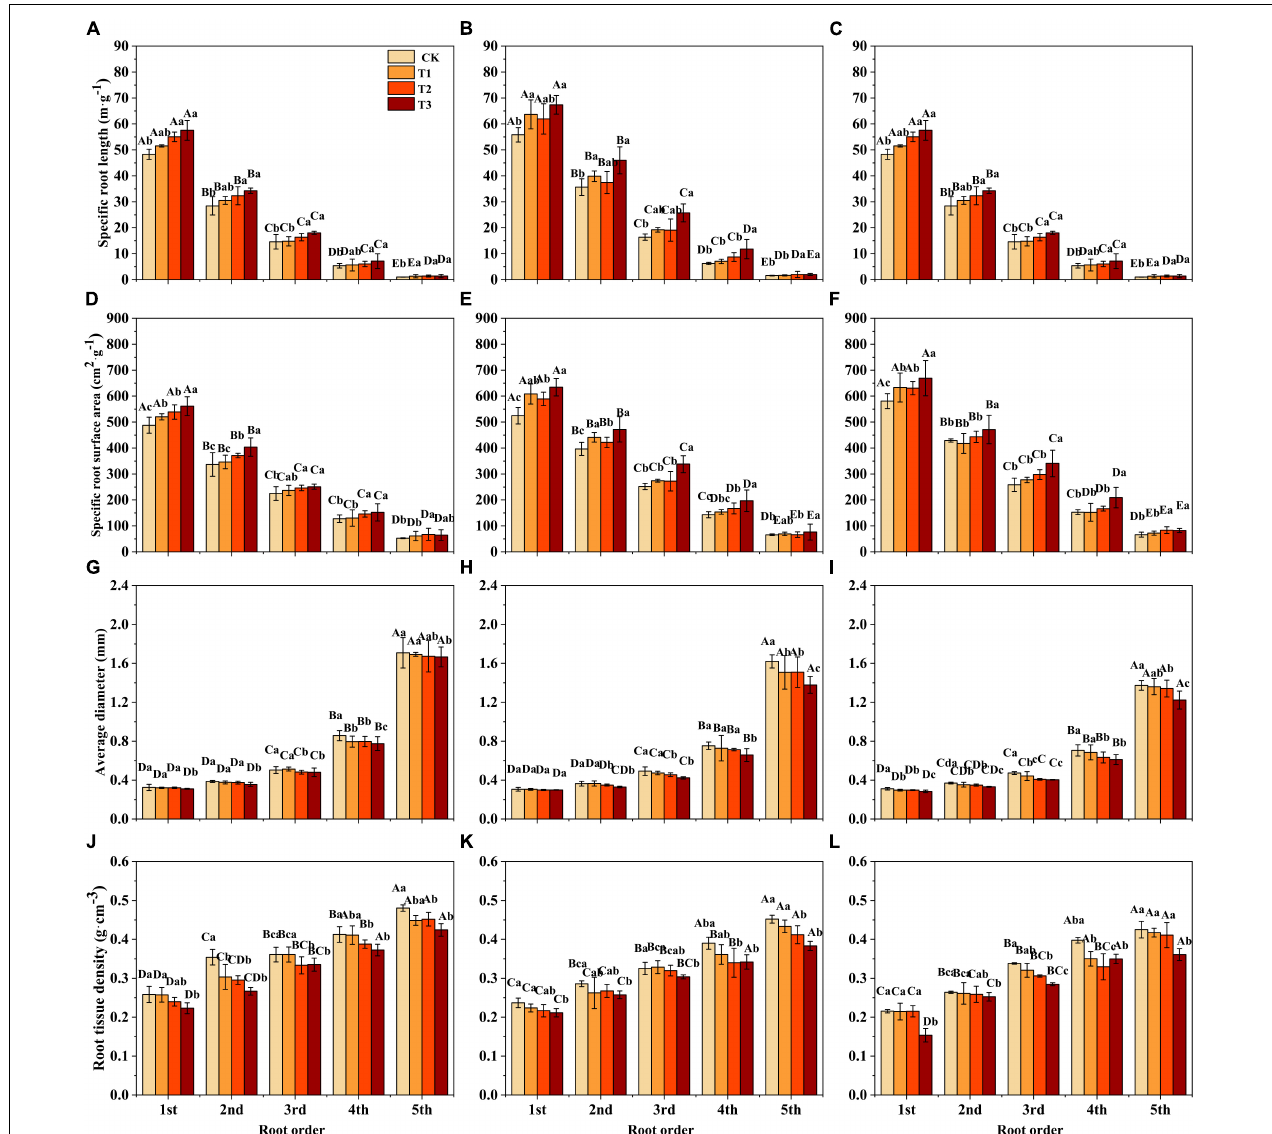
FIGURE 2 | The specific root length (SRL) (A–C) , specific root surface area (SRA) (D–F) , the average diameter (AD) (G–I) , and root tissue density (RTD) (J–L) of Fraxinus mandshurica seedlings in different drought intensities and soil substrates. The different lowercase letters denote significant differences among drought intensities ( p < 0.05). The different uppercase letters denote significant differences among root branch order ( p < 0.05). (A,D,G,J) Humus soil; (B,E,H,K) loam soil; (C,F,I,L) sandy-loam soil; CK: control; T1: mild drought; T2: moderate drought; T3: severe